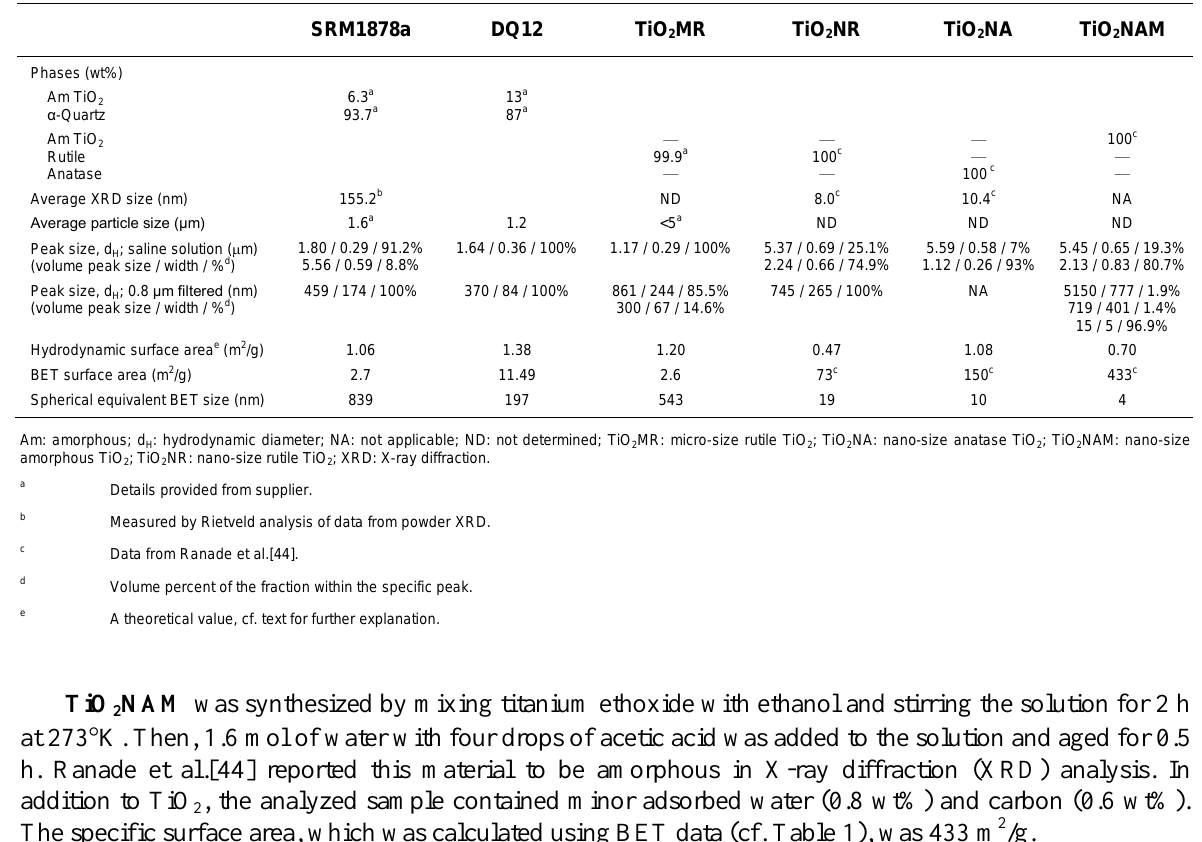
Summary of Selected Sample